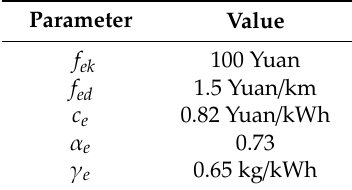
Table 5. Parameters of Capacitated Electric Vehicle Routing Problem with Time Windows (CEVRPTW) model.